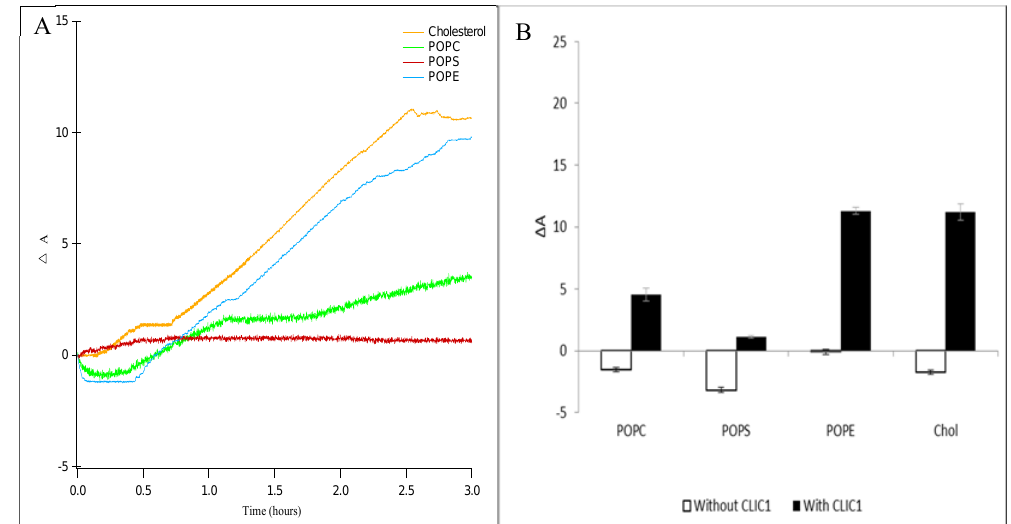
Figure 2. (A) Percent area expansion profiles for CLIC1 insertion into cholesterol (orange line), POPC (green line), POPS (red line) and POPE (blue line) monolayers on buffer subphase. (B) Corresponding percent area expansion profiles of different lipids or cholesterol monolayers without (white bars) and with (black bars) recombinant CLIC1 wild ‐ type protein after 3 hours following protein injection into the subphase. The insertion of CLIC1 in the different lipid or sterol monolayers shows two ‐ stages of interaction, an initial sharp increase in Δ A after a lag phase followed by a plateau and subsequent slow increase in Δ A over a period of 3 hours. ( n = 3)